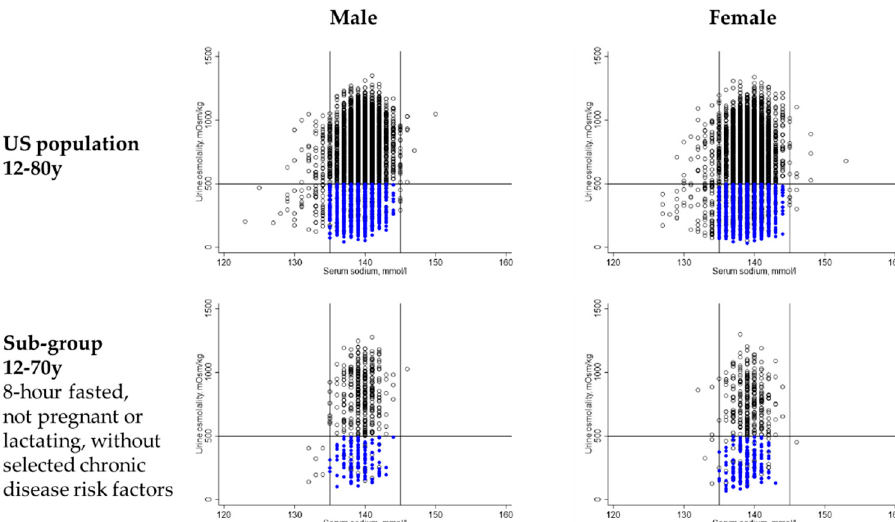
Figure 1. Serum sodium and urine osmolality of males and females in the US population. Each dot represents the serum sodium and urine osmolality of one NHANES 2009–2012 participant. Blue dots represent values that meet the hydration criteria (serum sodium 135–144 mmol/L and urine osmolality < 500 mmol/kg). Table 3. Proportion of the US population and sub-group without selected chronic disease risk factors that met the hydration criteria in 2009–2012 by life-stage group. Sub-Group without Selected Chronic US Population Disease Risk Factors Total Met Hydration Criteria